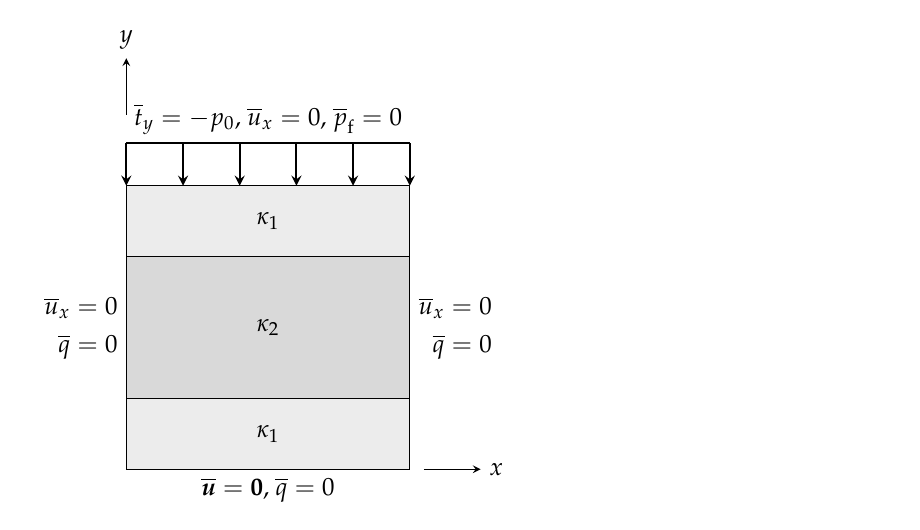
Figure 7. The Haga problem: Domain and boundary conditions. Table 2. The Haga problem: Load and material